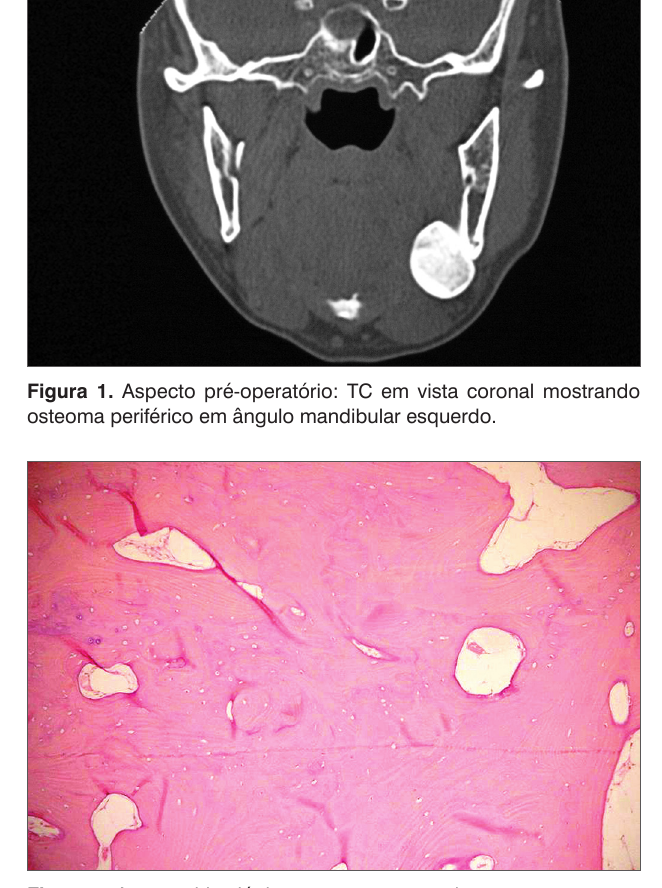
Figura 2. Aspecto histológico: osso compacto denso.